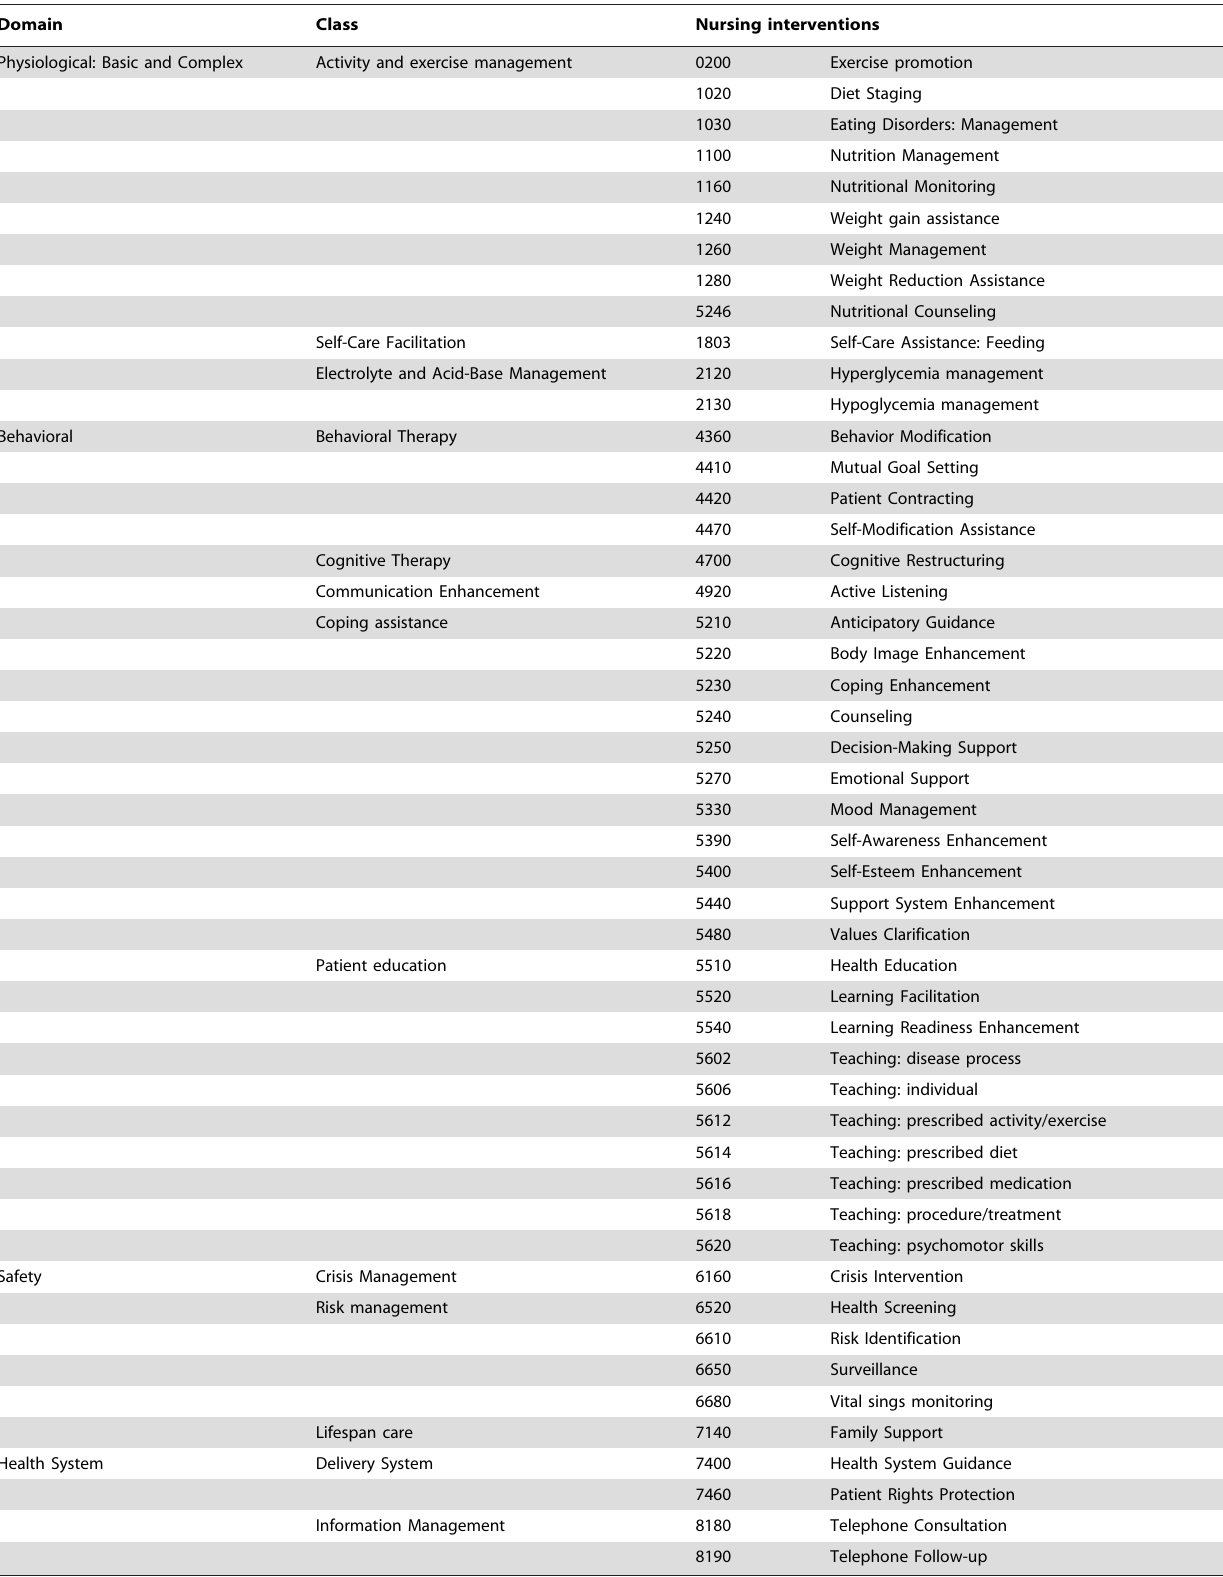
Table 2. Nursing interventions: domains, class, and titles.